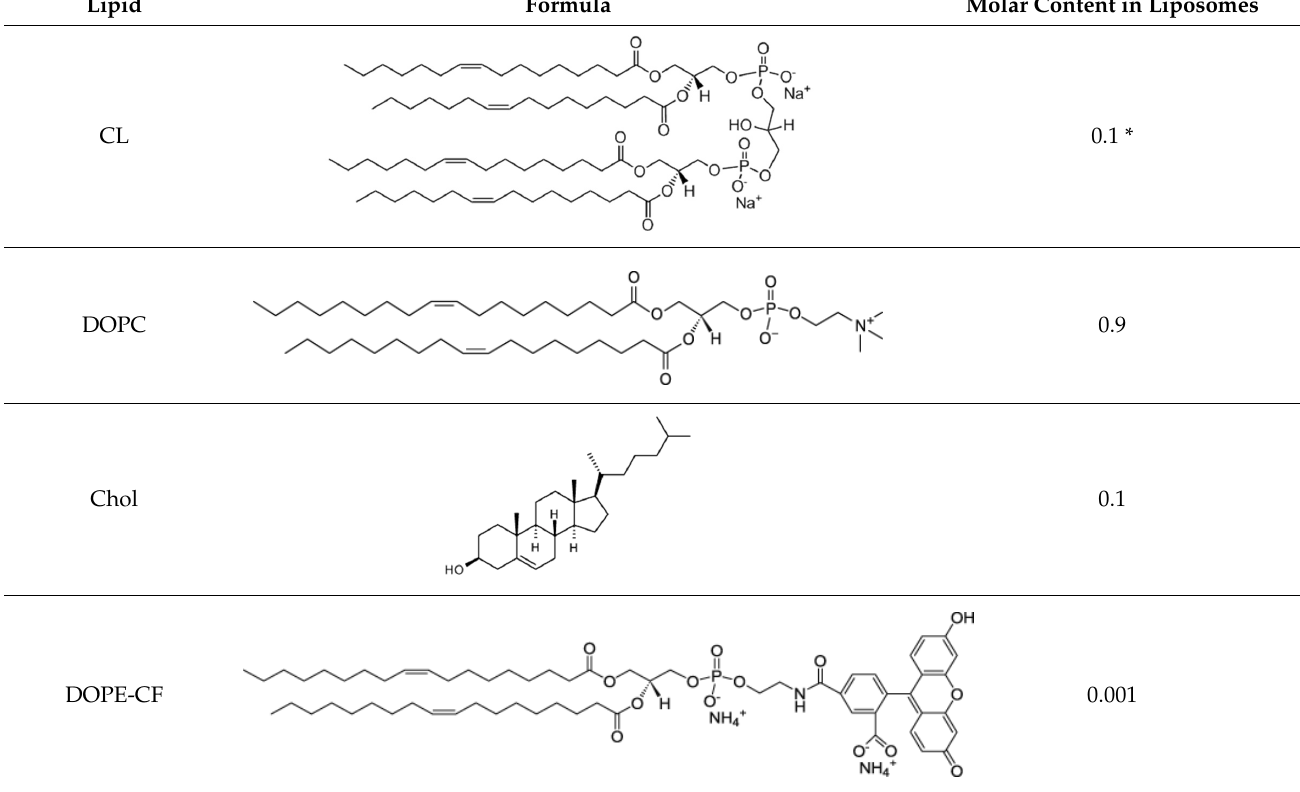
Table 3. Lipids for liposome preparation.